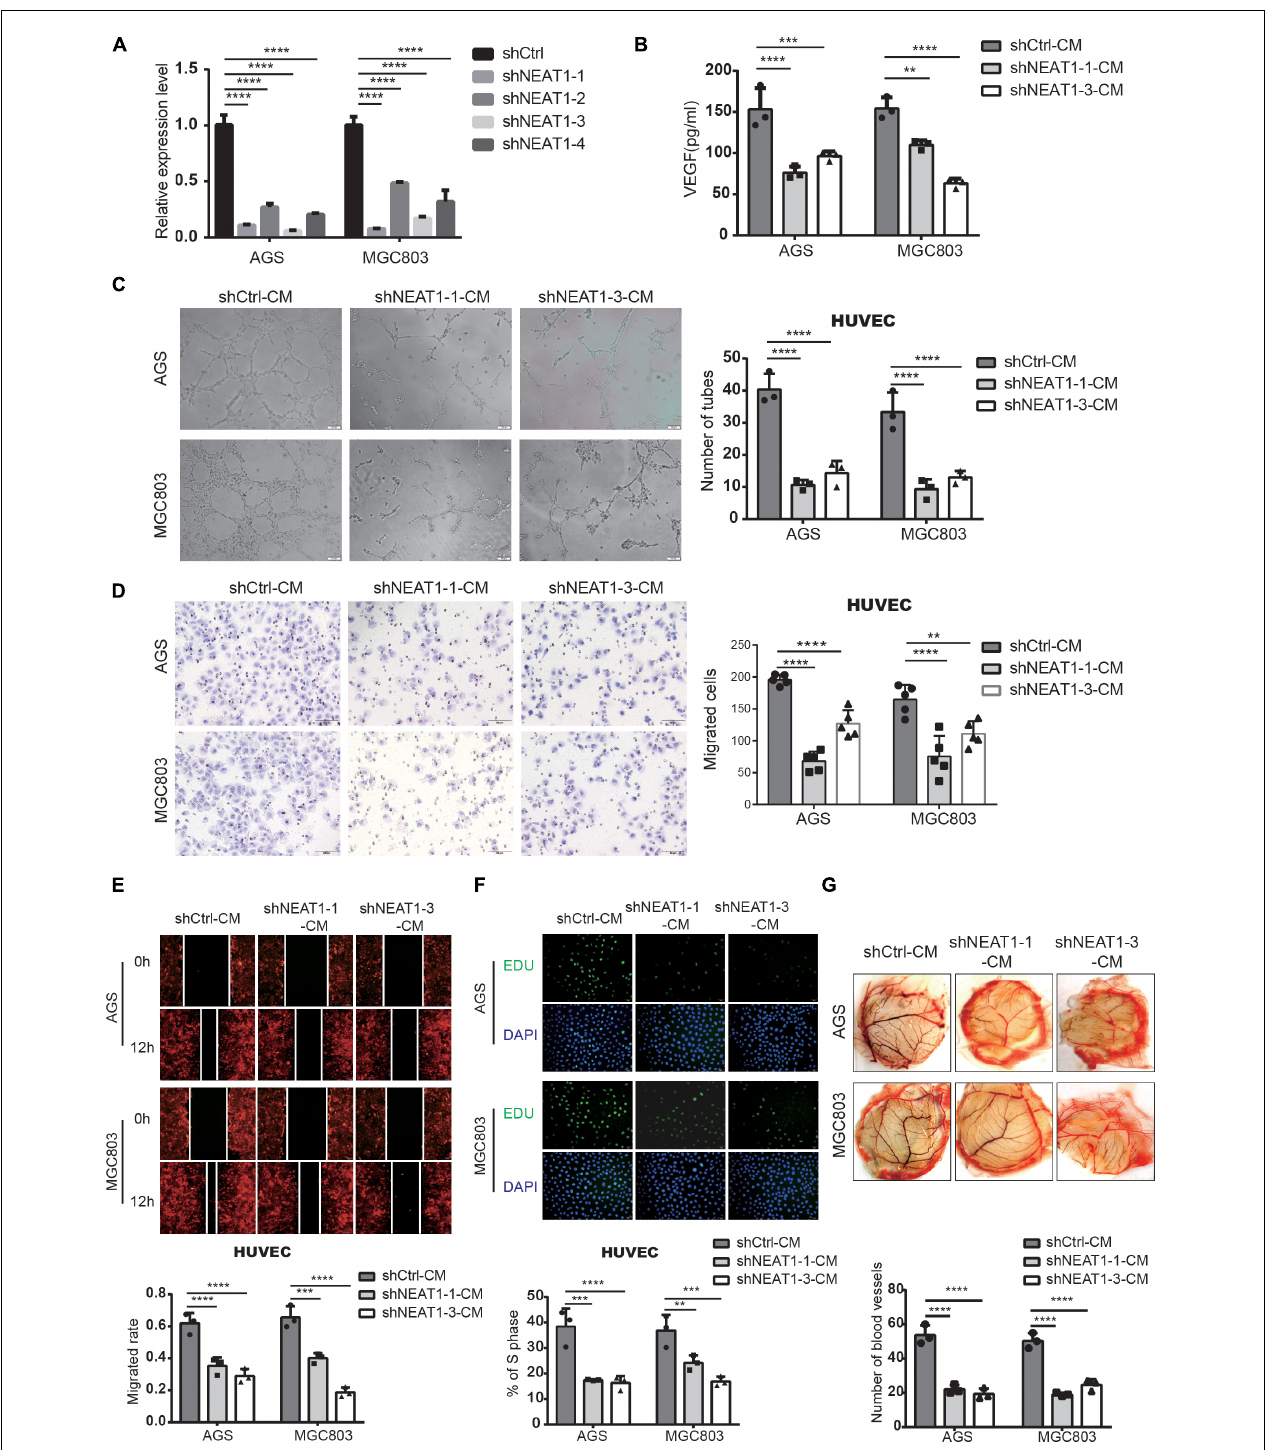
FIGURE 2 | Silencing of NEAT1 suppressed angiogenesis of GC cells. (A) RT-qPCR assay was used to verify the successful construction of NEAT1 knockdown GC cells. (B) The concentration of VEGF was detected in the culture medium of NEAT1-2 silenced AGS and MGC803 cells by ELISA assay (mean ± SD, n = 3). (C) Representative capillary tubule structures were shown for HUVECs treated with culture medium collected from the NEAT1 silenced cells. Scale bar represents 50 µ m. (D,E) Transwell (D) and wound healing (E) assay were performed in HUVECs to detect the effect of CM treatment on cell migration. Scale bar represents 50 µ m. (F) EdU assay was performed in HUVECs to detect the effect of CM treatment on cell proliferation. (G) Representative images of blood vessels formed in the CAM assay after CM treatment. ** P < 0.01, *** P < 0.001, **** P < 0.0001.